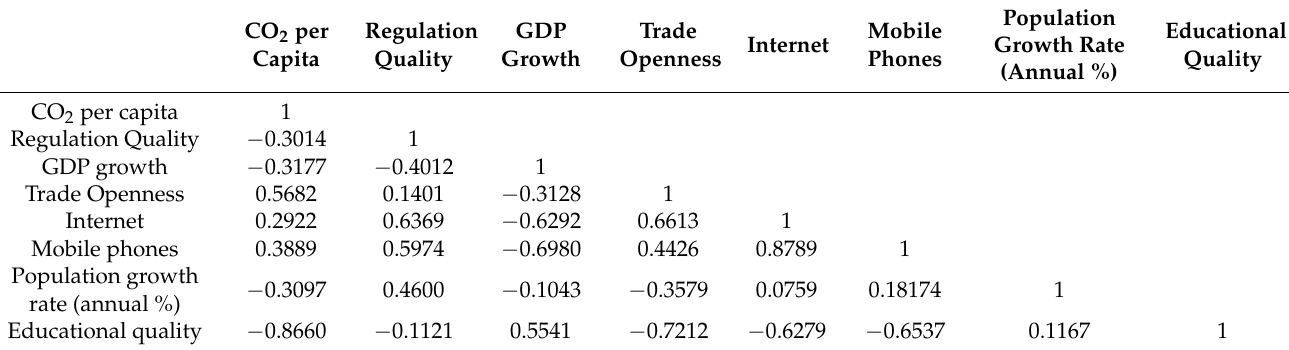
Table 3. Correlations